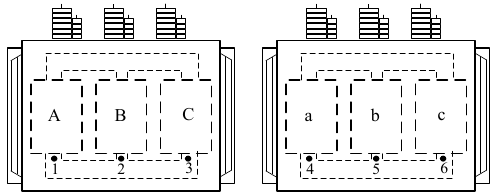
Fig. 6. Diagram of measuring point location of